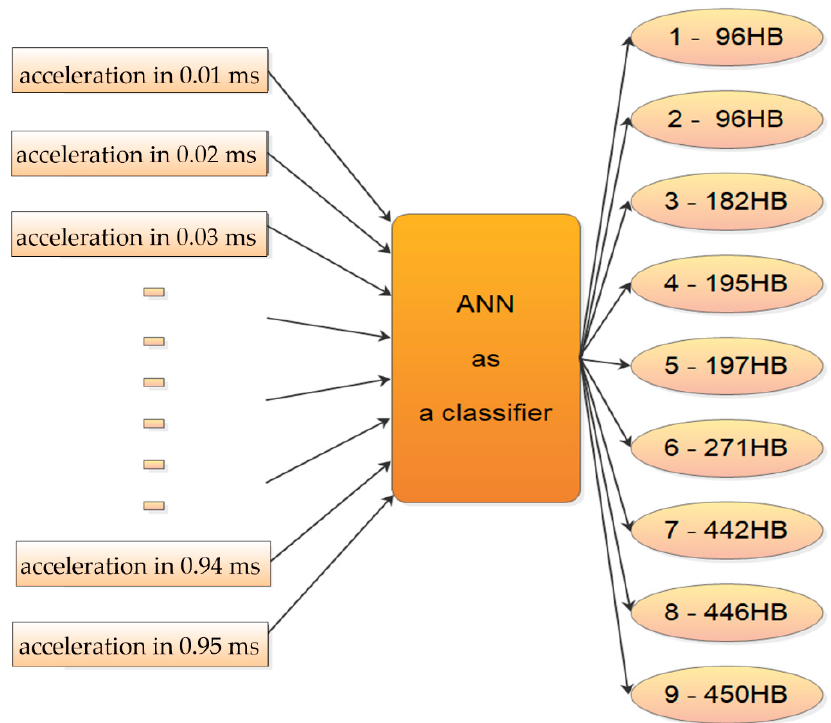
Figure 7. The scheme of classifying into nine classes of steel based on the intender acceleration.